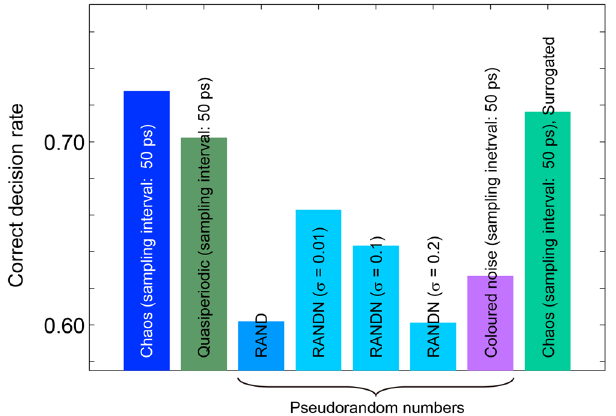
Figure 4. Comparison of learning performance (CDR at the cycle t = 5) by laser chaos, quasiperiodic signals, coloured noise signals, uniformly and normally distributed pseudorandom numbers, and surrogate laser chaos signals. The laser chaos signal sampled at 50-ps intervals exhibits the best performance compared with other cases, showing that the dynamics of laser chaos positively influences reinforcement learning